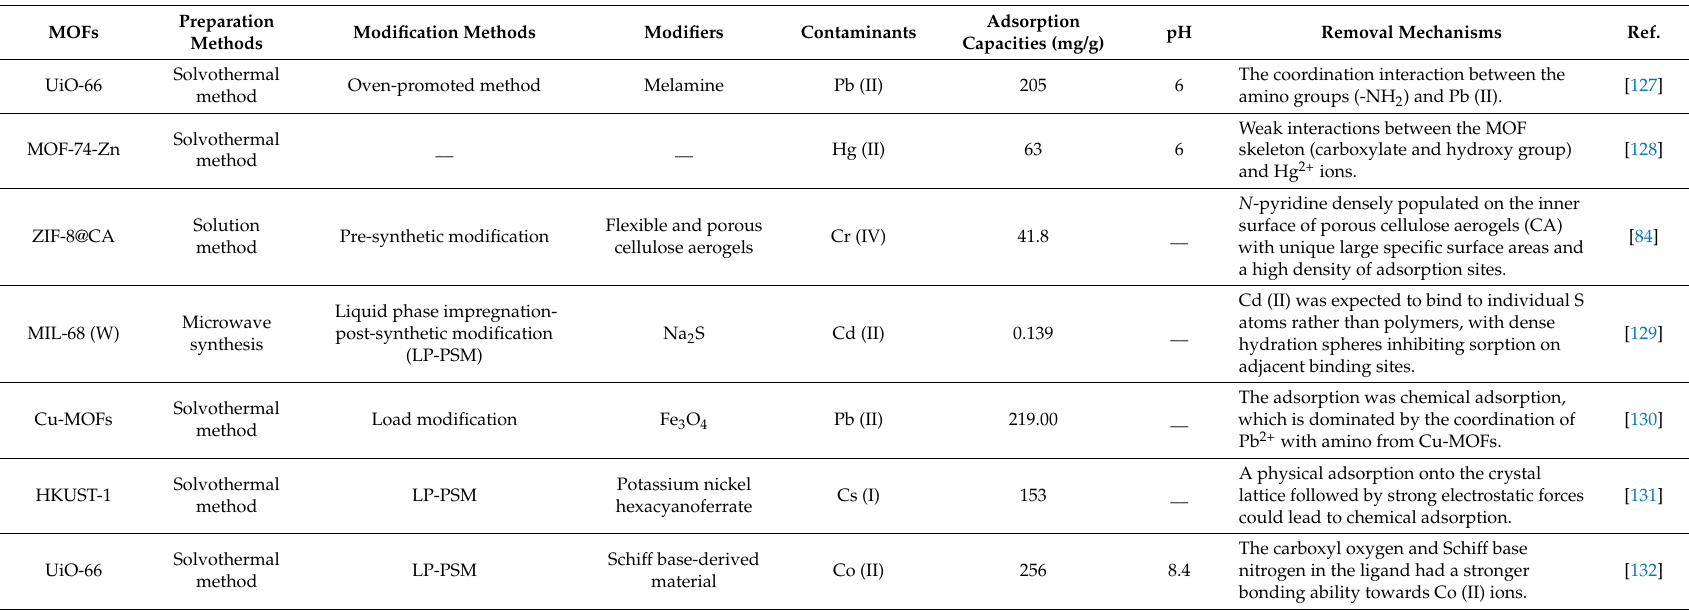
Table 3. The effects of various types of MOFs on the removal of heavy metal